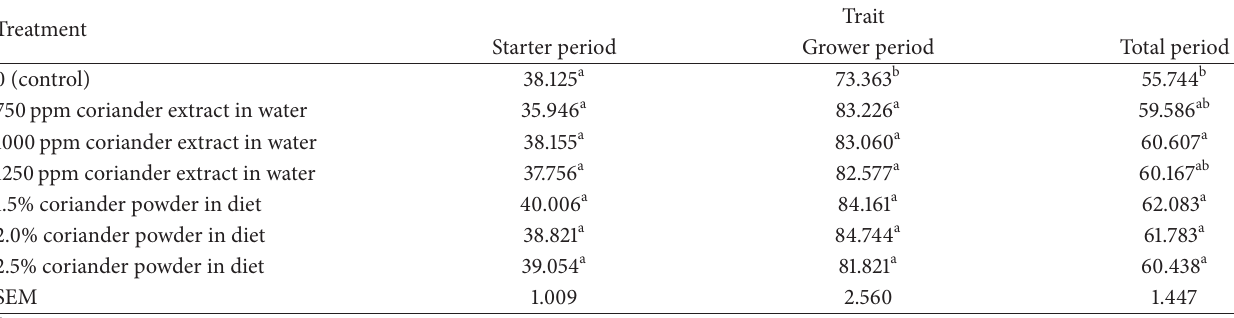
Table 5: Weight gain mean ( ± SEM) of Ross 308 broilers at starter (1–21 days), grower (22–42 days), and total periods (1–42 days) fed diets or water containing the different levels of coriander ( Coriandrum sativum L.) powder and extract (g/bird/day).